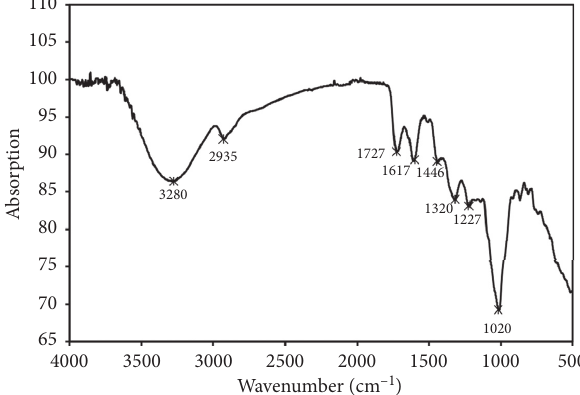
Figure 7: Infrared spectrum of Tunisian raw pomegranate